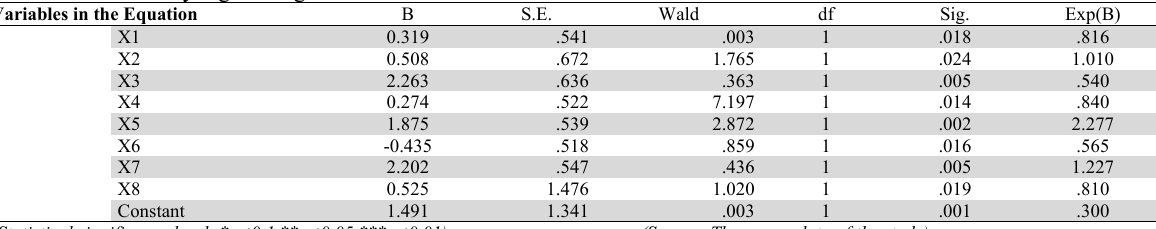
Results for the binary logistic regression model Variables in the Equation